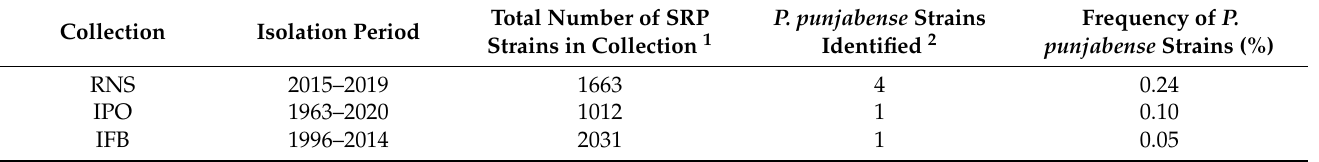
Table 3. Occurrence of P. punjabense strains in